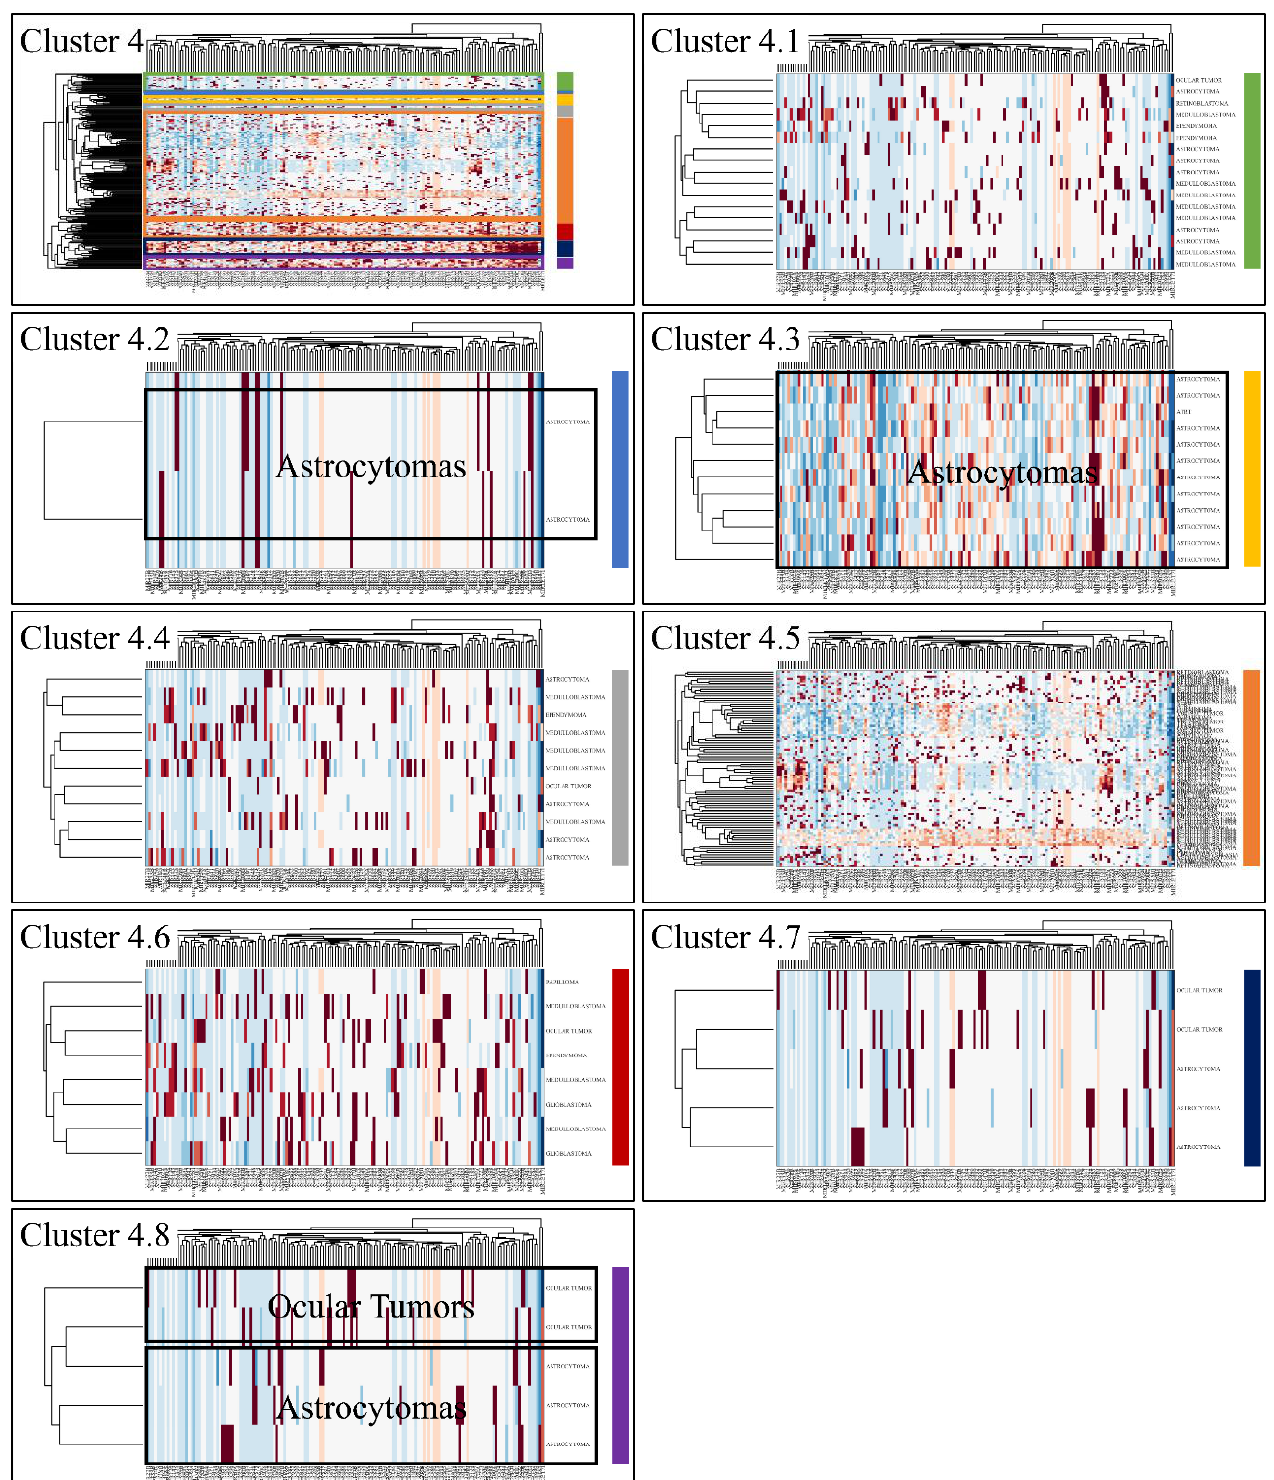
Figure 7. Hierarchical clustering (HCL) of cluster 4 as revealed previously by k-means clustering. The complete HCL is presented (Cluster 4) with its respective sub-clusters, denoted as clusters 4.1, 4.2, 4.3, 4.4, 4.5, 4.6, 4.7 and 4.8. In sub-cluster 4.2, 4.3 and 4.8 miRNAs grouped together astrocytomas and ocular